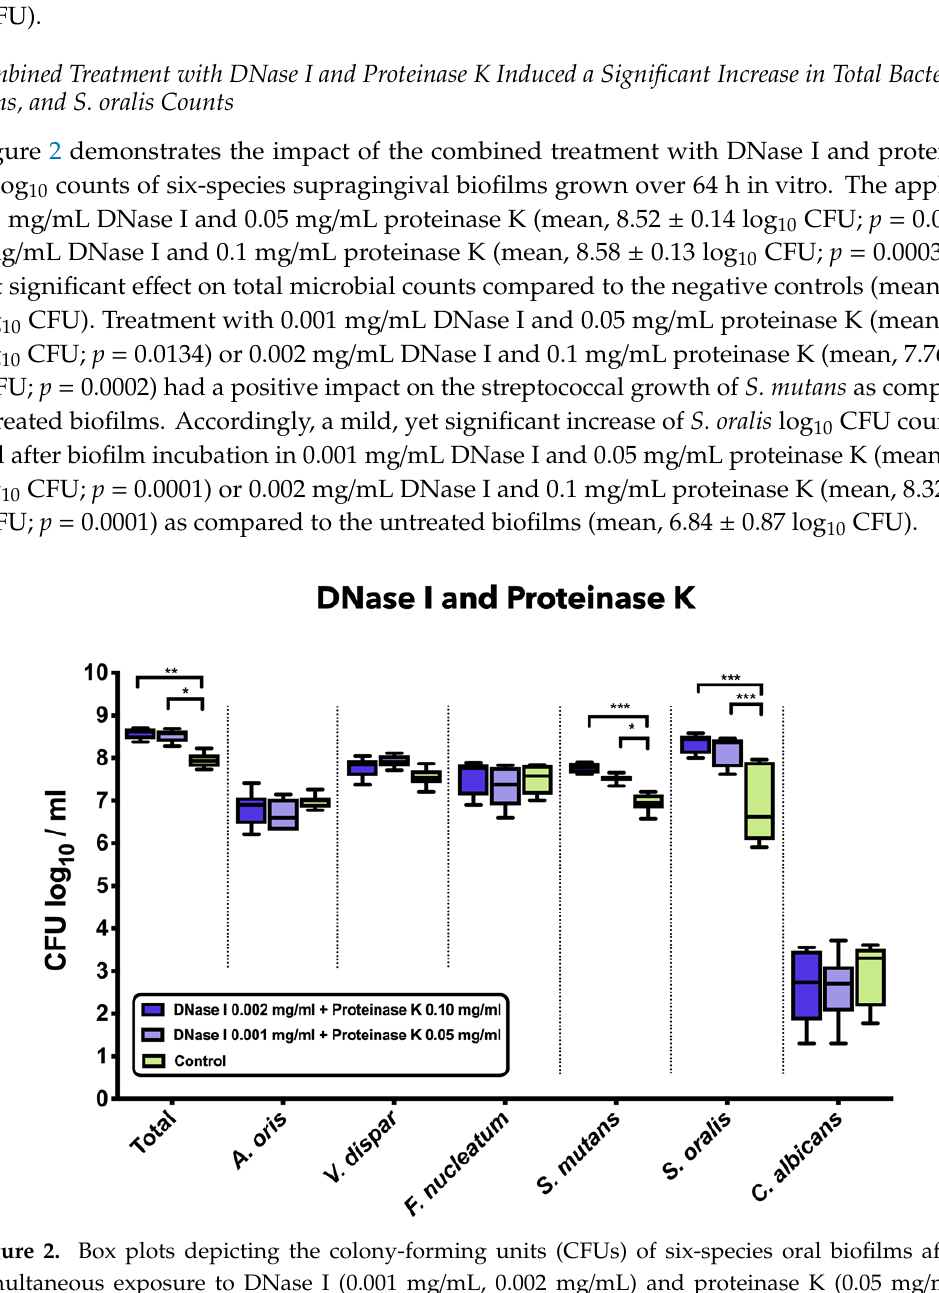
Figure 2. Box plots depicting the colony-forming units (CFUs) of six-species oral biofilms after simultaneous exposure to DNase I (0.001 mg/mL, 0.002 mg/mL) and proteinase K (0.05 mg/mL, 0.1 mg/mL). Untreated biofilms were also tested as negative controls. The CFUs are shown on a log 10 scale per millilitre (Log 10 / mL ). Statistically significant differences are indicated with asterisks (* p < 0.030, ** p < 0.006, *** p <